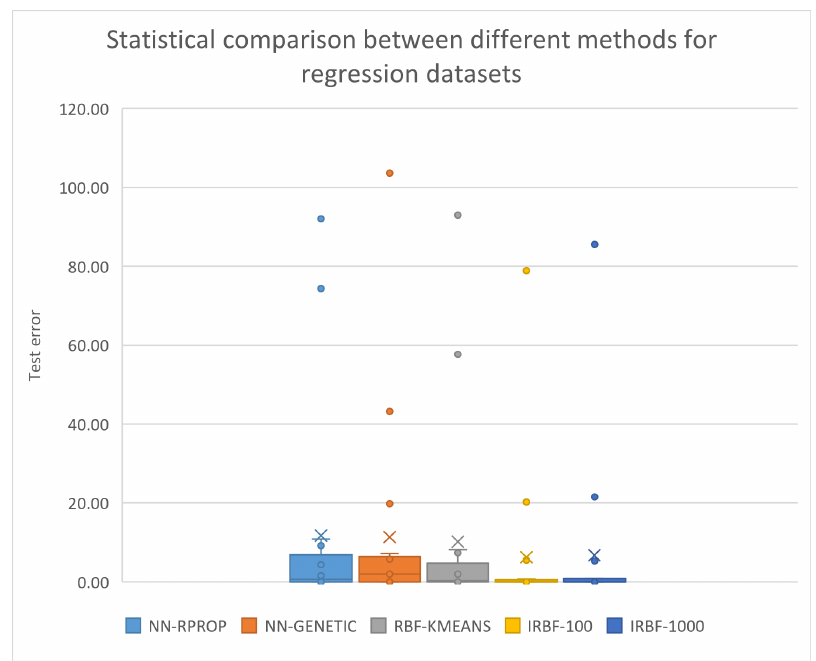
Figure 5. Graphical comparison of the methods for the regression